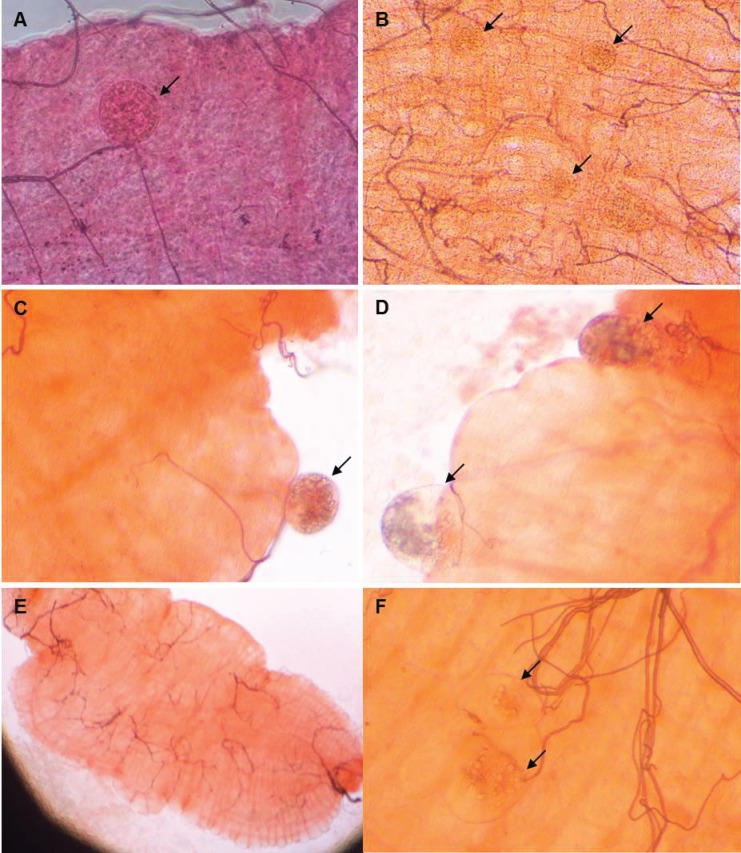
Structures observed on mosquito midguts.(A) and (B) Oocyts observed on midguts of mosquitoes fed with P. vivax infected blood. (C) and (D) Other ovoid structures observed on midguts of mosquitoes fed with P. vivax infected blood. (E) and (F) Midguts of mosquitoes fed with non-infected blood (negative control). No structures were present on the mosquito midgut represented in panel E. Panel F illustrates ovoid structures observed on the mosquito midguts of some negative controls. Magnification: 20x in panels A, C, D and F; 10x in panel B; 4x in panel E.